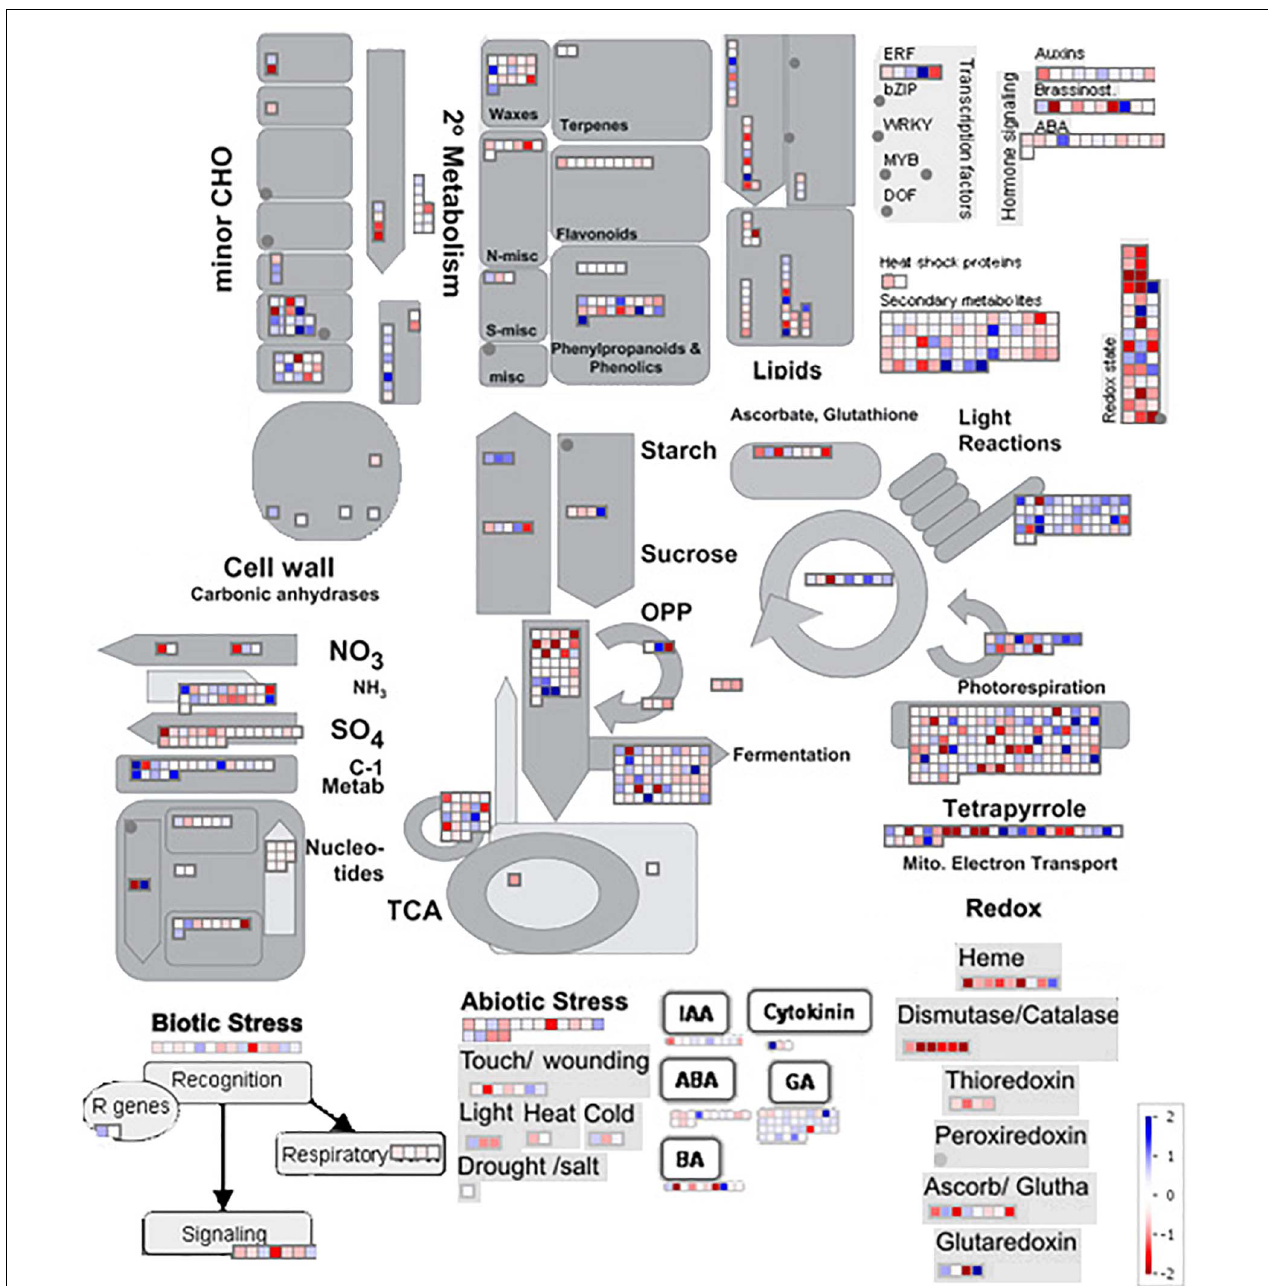
FIGURE 6 | MapMan functional annotation showing parts of the metabolism overview, hormones, biotic stress, abiotic stress, and redox reaction pathways. Color scales from –2 (intense red) to +2 (intense blue), in log2 fold